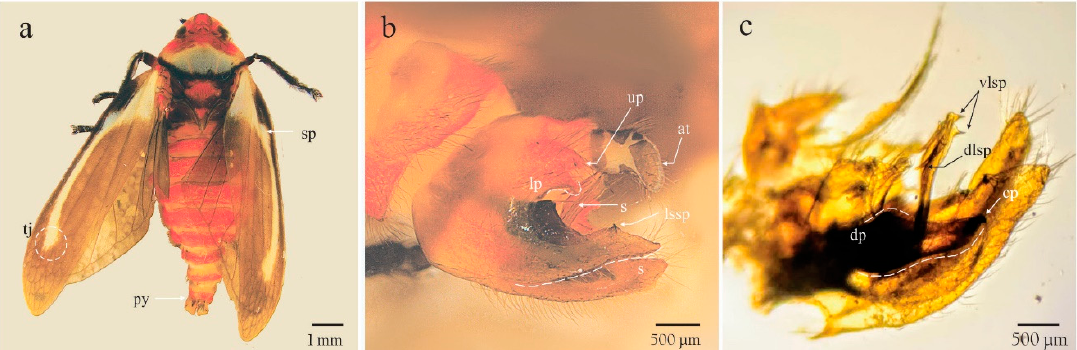
Figure 3. Male adult of Ocoaxo assimilis . a) dorsal habitus showing a basal spot joined to a cream yellow longitudinal line (sp), a) poorly delineated “tajamata” (tj) on both alar appendages